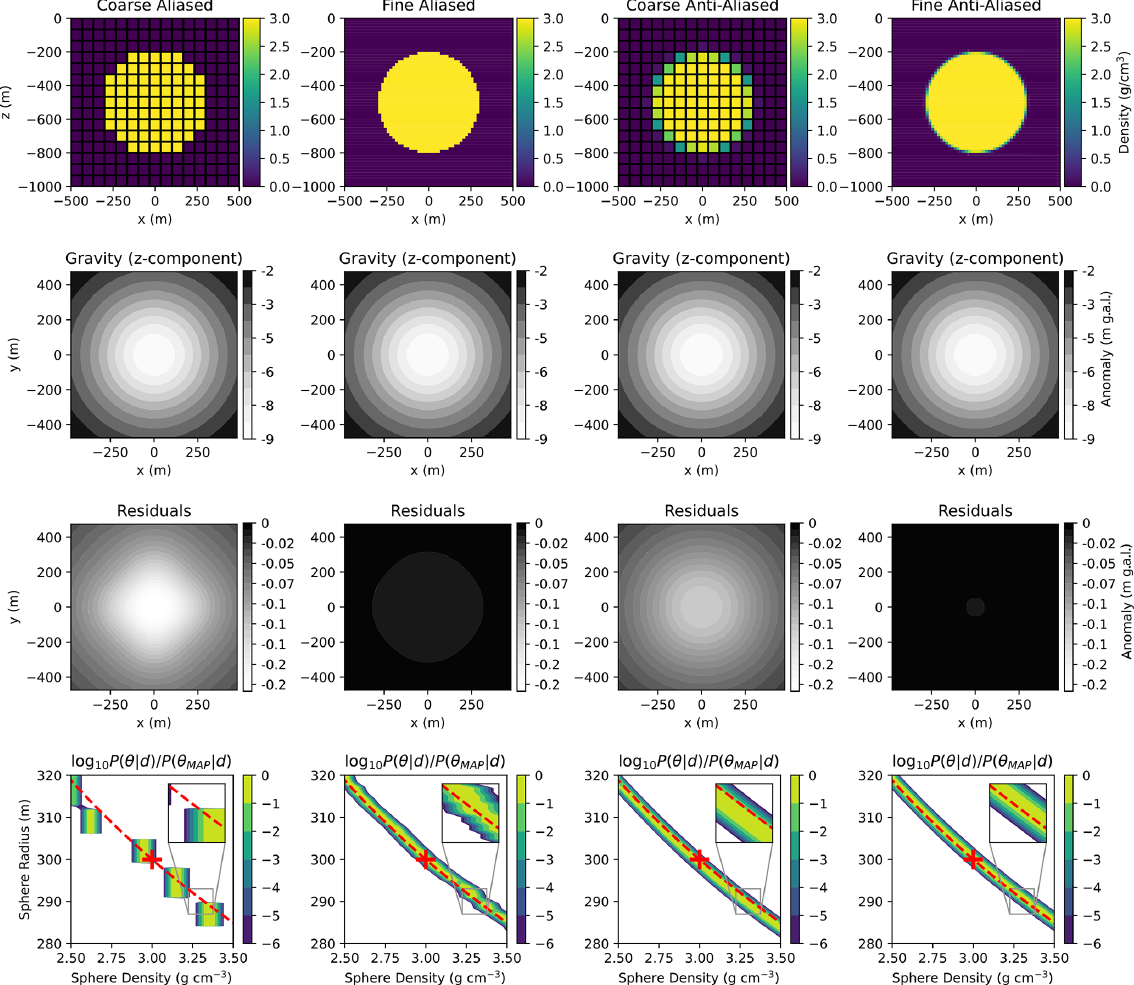
Figure 1. Calculation of the posterior distribution for the radius and density of a uniform spherical inclusion from gravity inversion. Top row: cross section of 3-D rock density field for the true model from which the data are generated. Second row: simulated gravity field at the surface. Third row: residuals of simulated gravity field from the analytic solution. Bottom row: cross section through the posterior for an independent Gaussian likelihood. Discretization schemes shown (columns, left to right): coarse aliased mesh (15 3 cells), fine aliased mesh (60 3 cells), coarse anti-aliased mesh, fine anti-aliased mesh. The true parameters are shown by the red crosses, while the dashed red lines indicate the degeneracy relation in Eq. (2) that constitutes the maximum-likelihood ridge of the analytic solution.